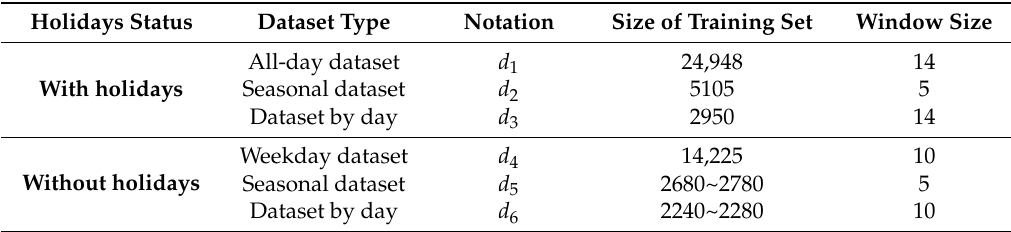
Figure 5. Comparisons of power demand: ( a ) average seasonal power demand by year; ( b ) average power demand for weekdays and weekends by week. Table 2. Training sets used in the experiments.